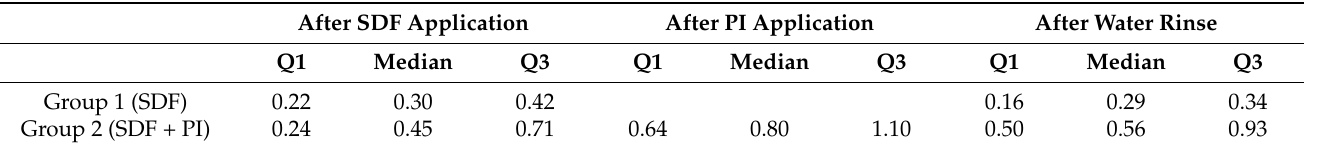
Table 1. Percentage increase of the preoperative radiopacity of the carious lesions after SDF applica- tion, PI application, and rinse with 15 mL water (values expressed as lower quartile (Q1), median and upper quartile (Q3)).